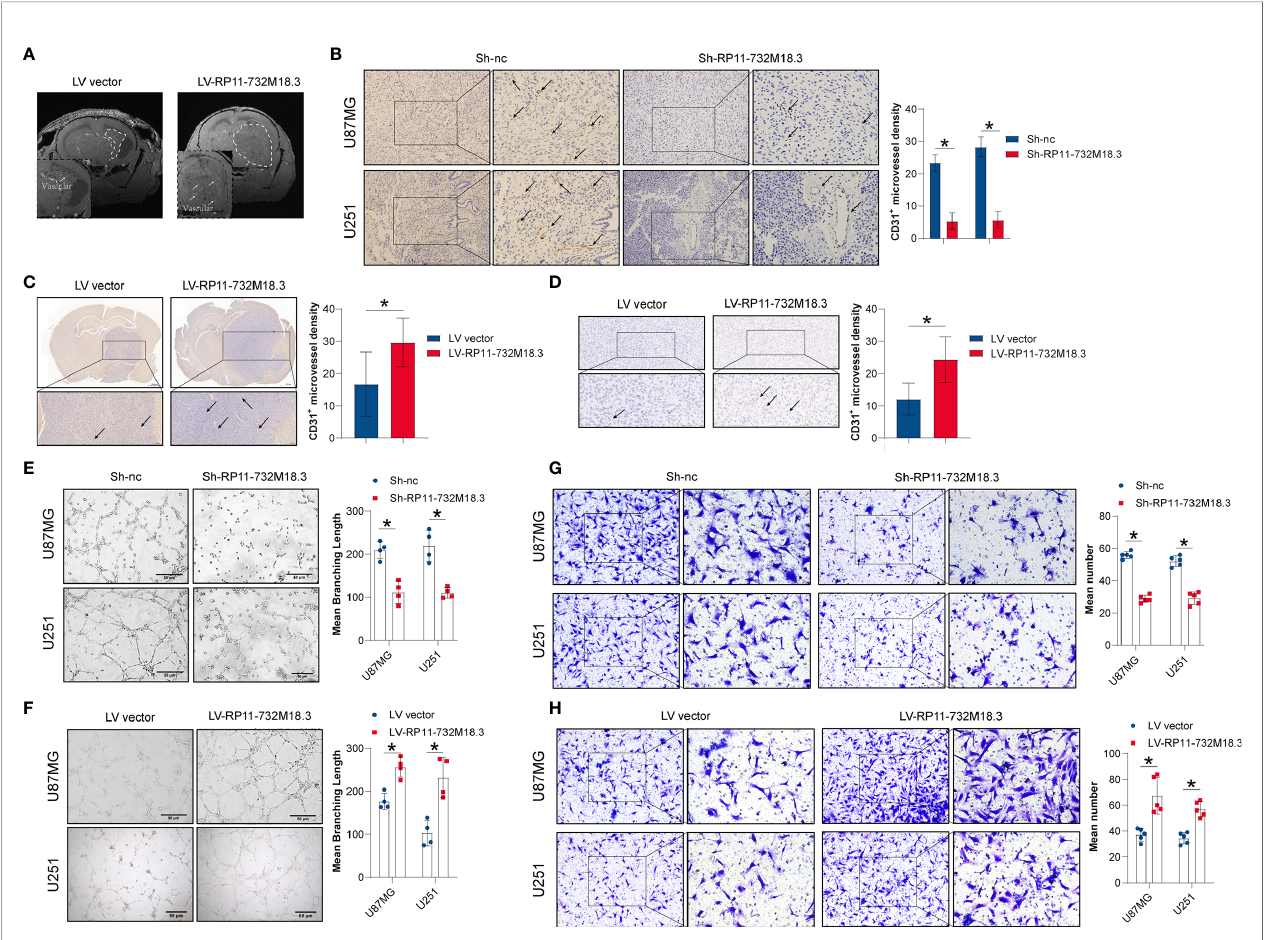
FIGURE 2 | lncRNA RP11-732M18.3 promotes tumor angiogenesis. (A) Nude mice were implanted intracranially with U87MG cells stably overexpressing lncRNA RP11- 732 M18.3. T2-weighted images of the mouse brain were obtained using a small animal MRI system. Arrow indicates the microvascular compartment. Overexpression of lncRNA-RP11-732M18.3 promotes glioma growth and increases microvascular density (n = 10 animals in each group). (B) Knockdown of lncRNA-RP11-732M18.3 inhibited tumor angiogenesis in vivo . Left: Representative images of CD31 staining of xenografts. Right: Quantitative analysis of newly formed vessels. All experiments were performed in triplicate (n = 5, * p < 0.05). (C) Representative immunohistochemistry (IHC) images with a CD31 antibody and quanti fi cation of IHC results in the intracranial orthotopic glioma model (n = 10 animals in each group. * p < 0.05). (D) Representative IHC images with a CD31 antibody and quanti fi cation of IHC results in the xenograft nude mouse model (n = 6 animals. * p < 0.05). (E, F) Knockdown of lncRNA-RP11-732M18.3 inhibited tumor angiogenesis in vitro , while lncRNA-RP11-732M18.3 overexpression promoted angiogenesis in vitro . All experiments were performed in triplicate (n = 4, * p < 0.05). (G, H) Knockdown of lncRNA-RP11-732M18.3 inhibited tumor angiogenesis in vivo , and lncRNA-RP11-732M18.3 overexpression promoted angiogenesis in vivo . All experiments were performed in triplicate (n = 5, * p <